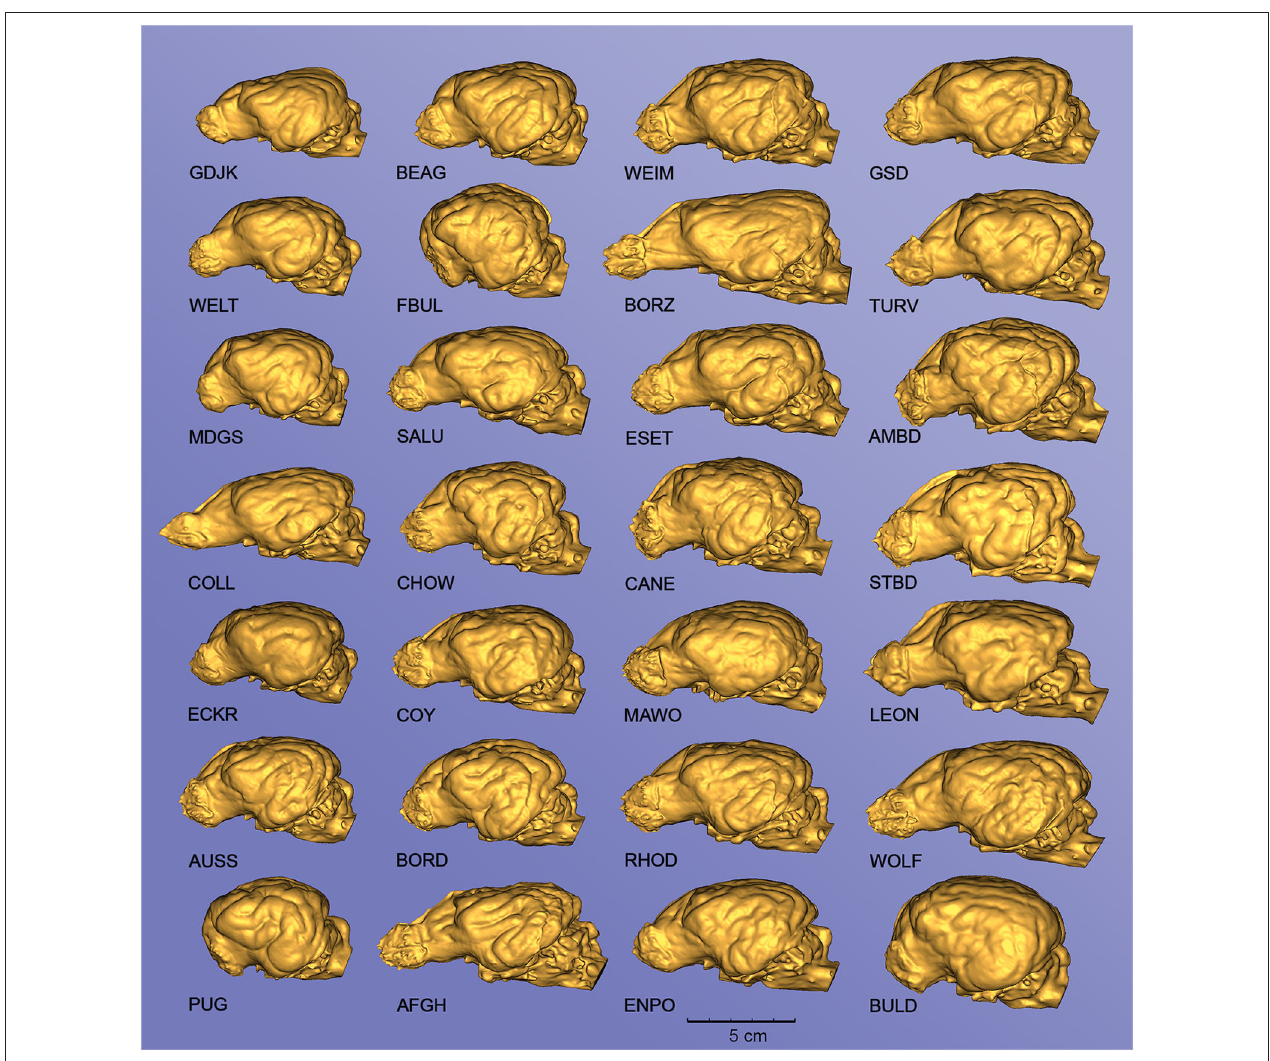
FIGURE 10 | Endocasts from different canine specimens, showing the diversity of surface morphology. Left lateral view. GDJK, Golden jackal; BEAG, Beagle; WEIM, Weimaraner; GSD, German shepherd dog; WELT, Welsh terrier; FBUL, French bulldog; BORZ, Borzoi; TURV, Belgian shepherd dog (Tervueren); MDGS, Medium German spitz; SALU, Saluki; ESET, English setter; AMBD, American bulldog; COLL, Collie; CHOW, Chow chow; CANE, Cane corso; STBD, Saint Bernard; ECKR, English cocker spaniel; COY, Coyote; MAWO, Maned wolf; LEON, Leonberger; AUSS, Australian shepherd; BORD, Border collie; RHOD, Rhodesian ridgeback; WOLF, Gray wolf; PUG, Pug; AFGH, Afghan hound; ENPO, English pointer; BULD, English bulldog. The endocasts are grouped into columns according to an increasing total volume [thus the top left endocast (GJDK) represents the smallest endocast, and the bottom right (BULD) has the largest